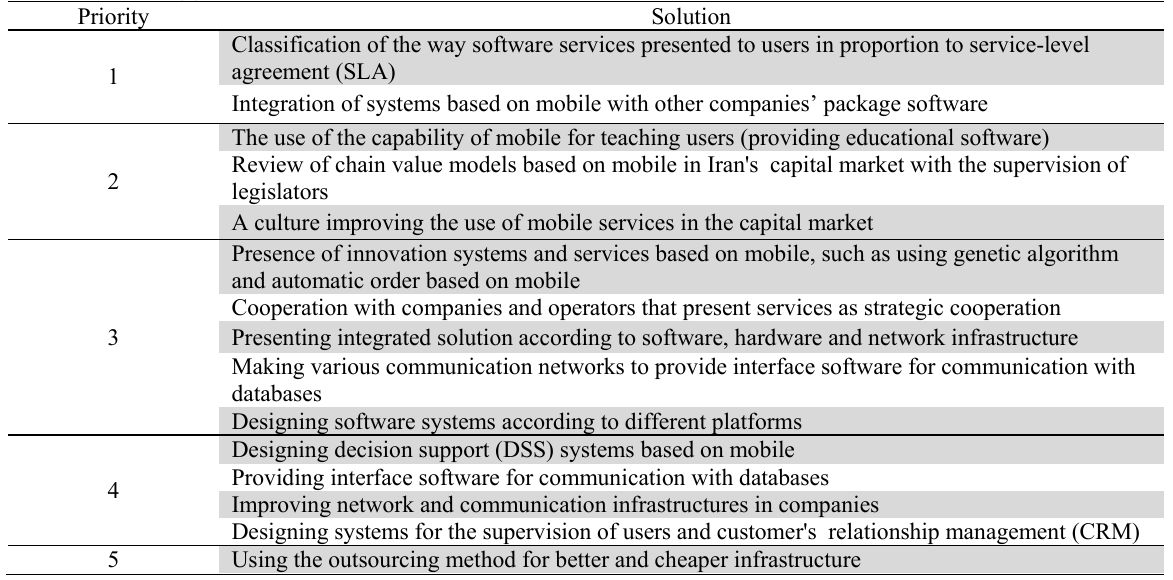
Prioritize of suggested